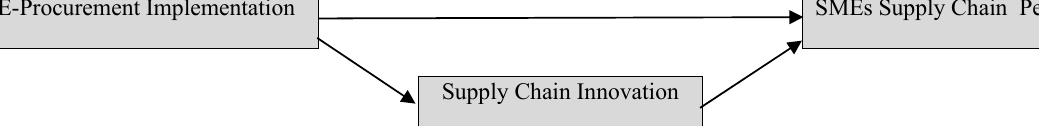
Fig. 1. Research Framework